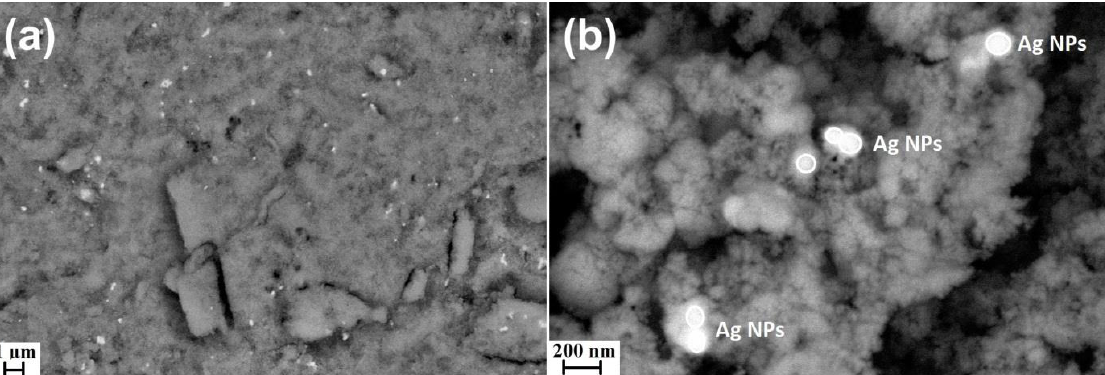
Figure 2. SEM images of ZnO+1%Ag NPs. ( a ) and ( b ) images taken with the angle-selective backscatter detector. Image magnifications: ( a ) 10,000×; ( b ) 100,000×.